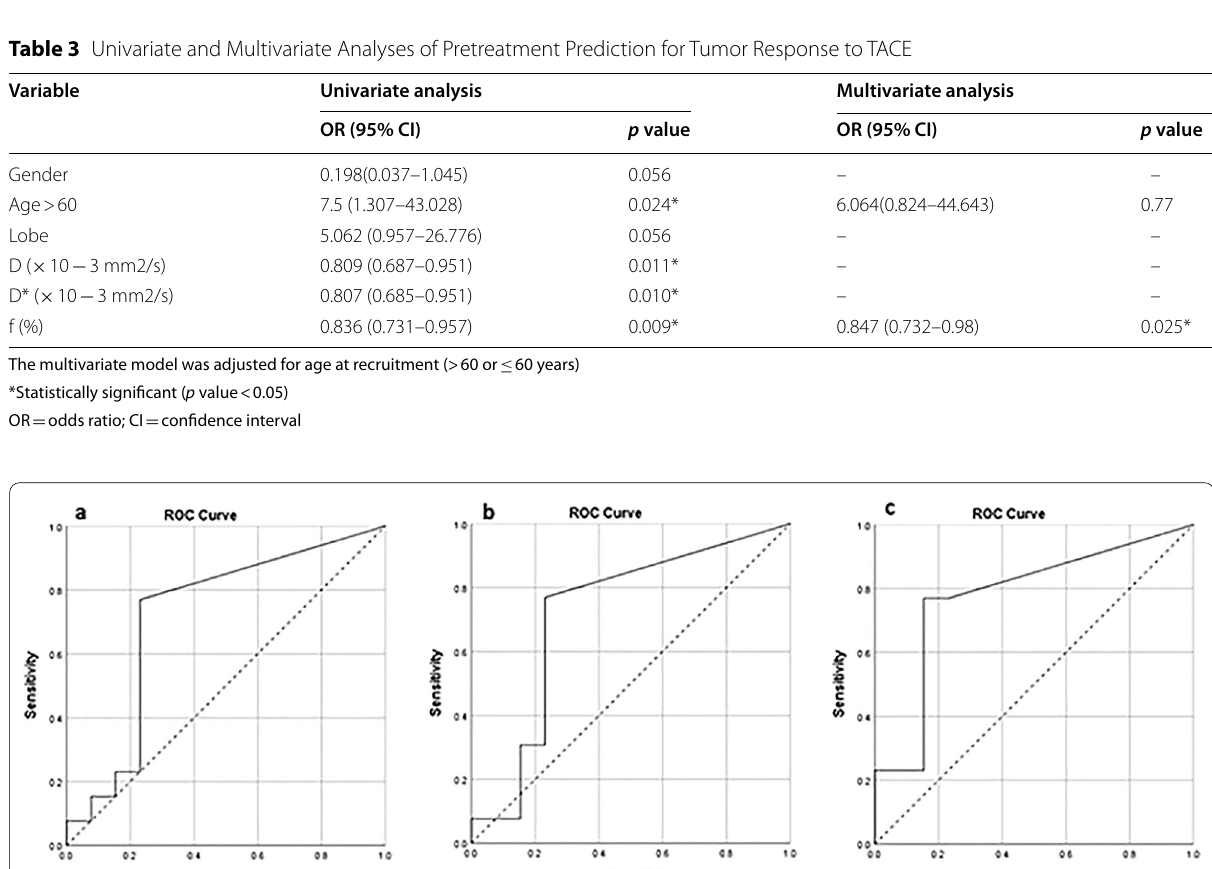
Table 3 Univariate and Multivariate Analyses of Pretreatment Prediction for Tumor Response to TACE